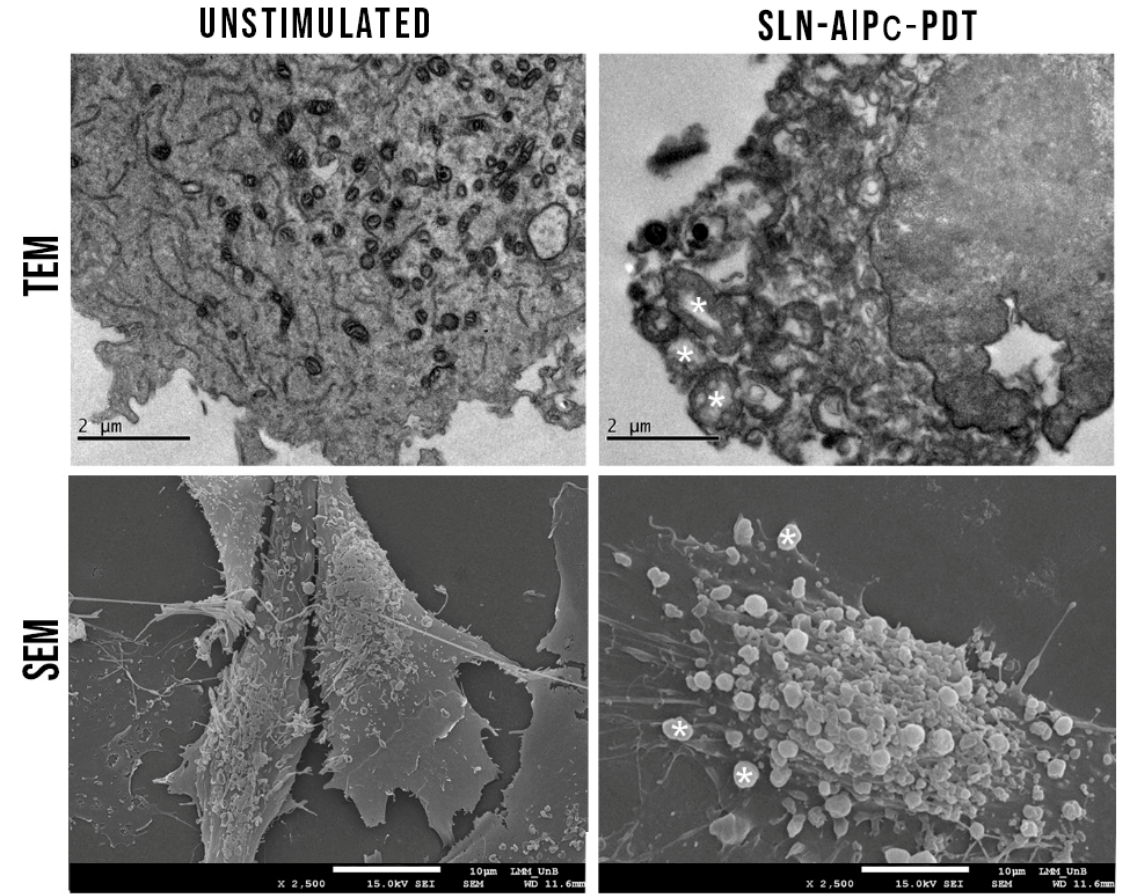
Figure 15. B16-F10 cells morphology in TEM and SEM after the PDT treatment with SLN-AlPc; it was also possible to observe formation of apoptotic bodies (*) and cytoplasmic bumps.